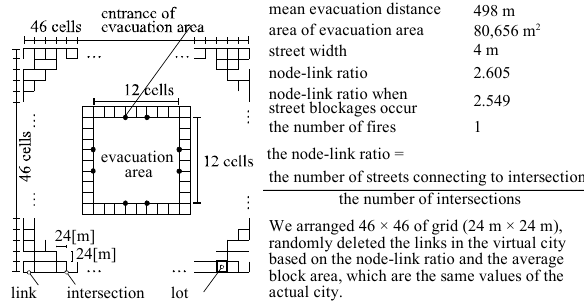
Figure 1. Outline of a virtual city